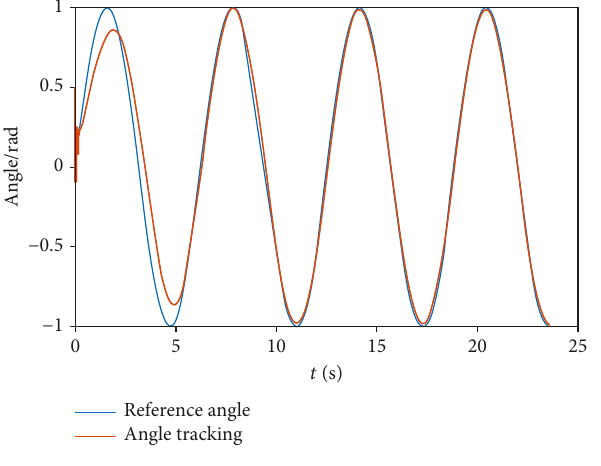
Figure 3: Angle tracking